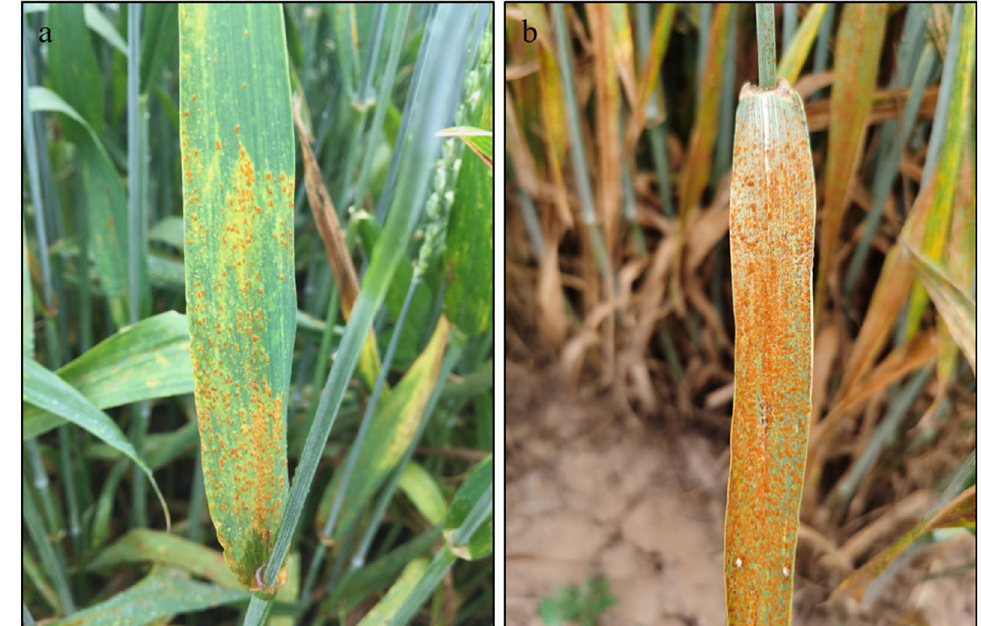
Fig. 2 Symptoms of leaf rust on wheat leaves. a A few uredia at early stage of the development. b Numerous uredia produced on a leaf at late stage of the